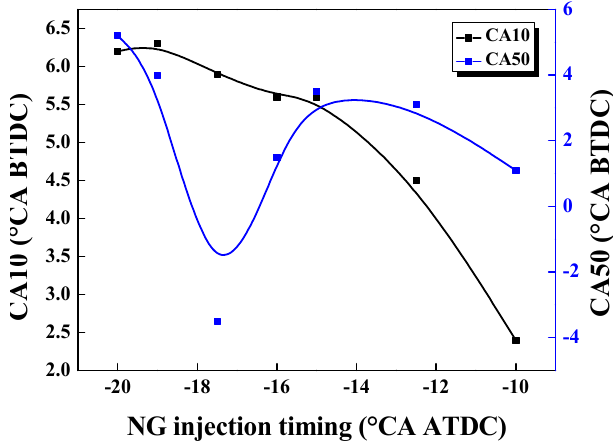
Figure 17. Changes in CA10 and CA50 and NG injection timing.